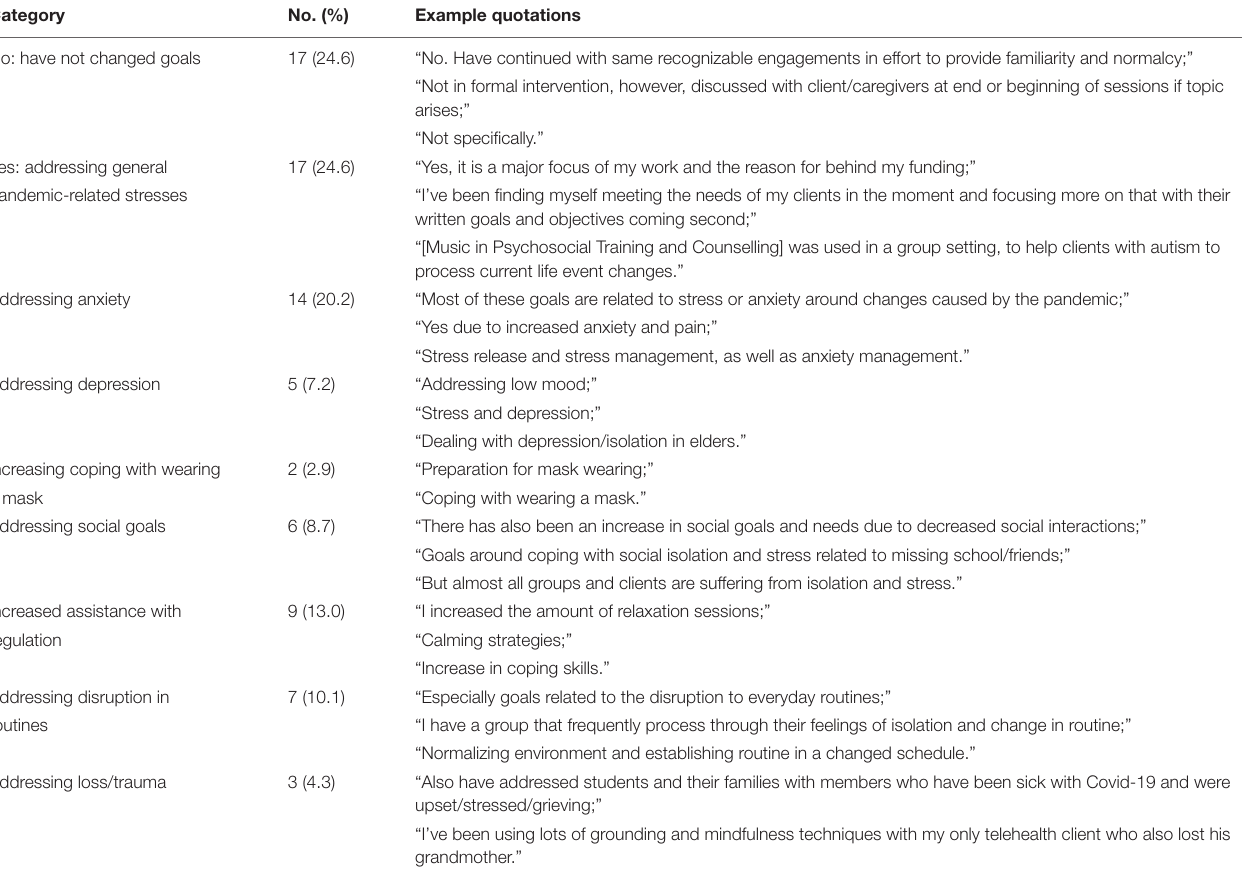
TABLE 6 | New goals related to pandemic. Category Example